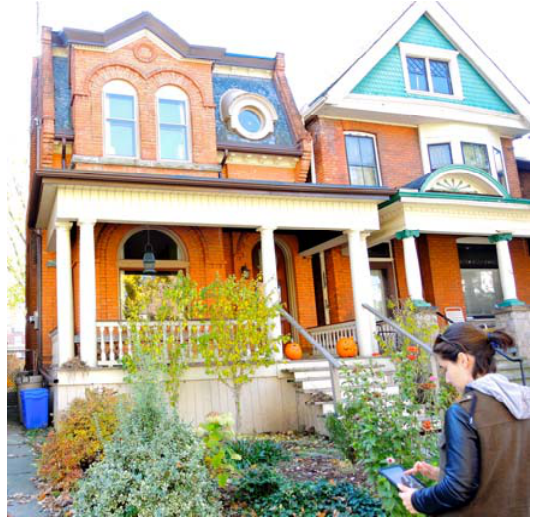
Figure 3. Surveyor using tablet survey app in the field